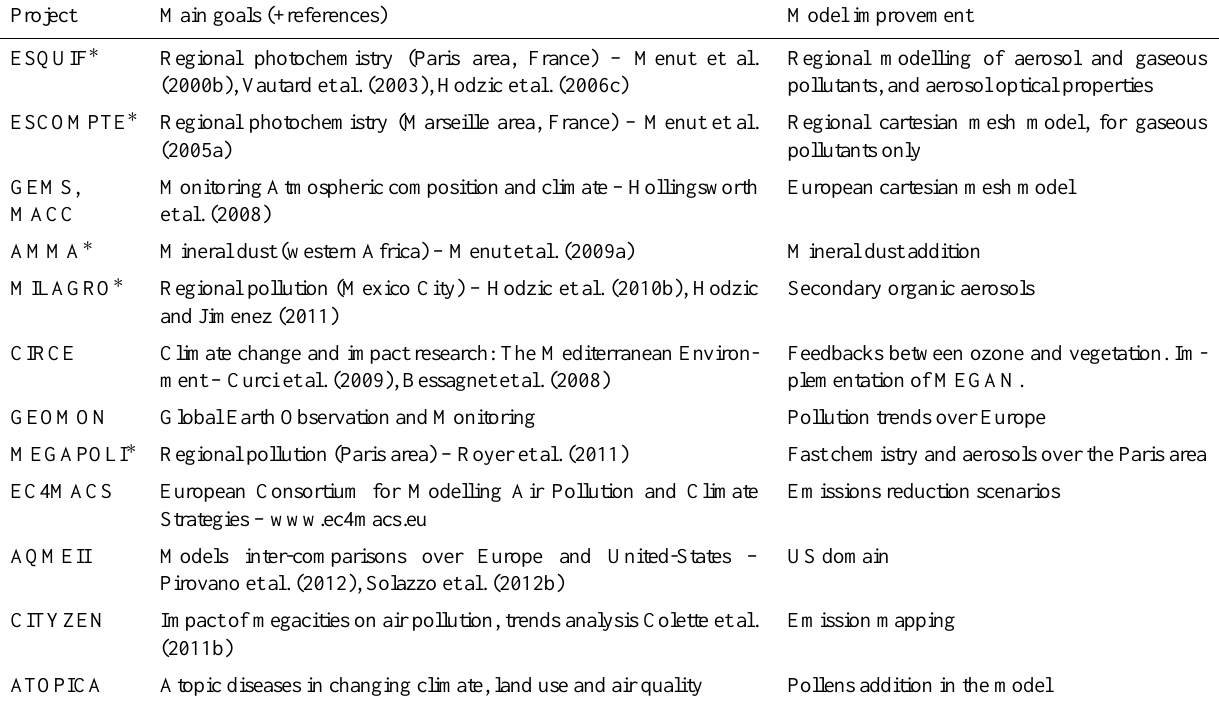
Table 8. International projects involving CHIMERE (in chronological order). Names with an ∗ correspond to field campaigns for which meteorological and chemical data were used to validate CHIMERE.